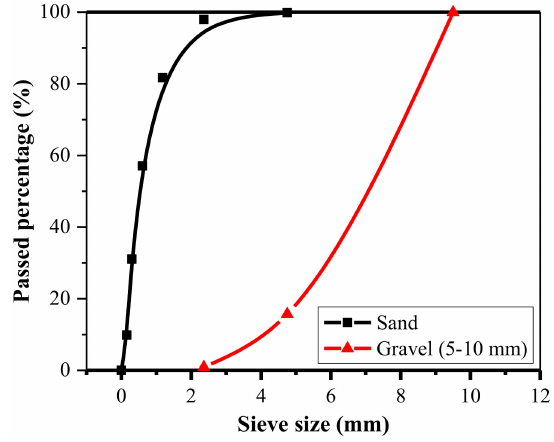
Figure 1. Gradation curves of fine and coarse aggregates.